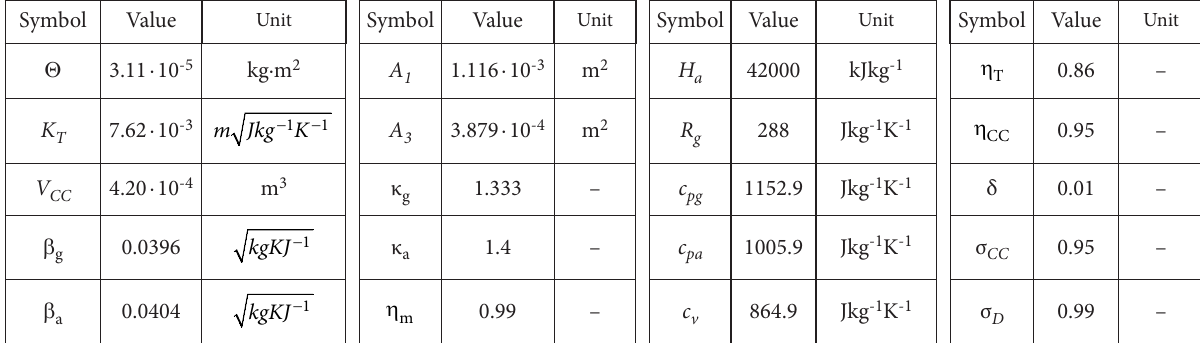
Table 1. Geometry of gas turbine and physical properties of